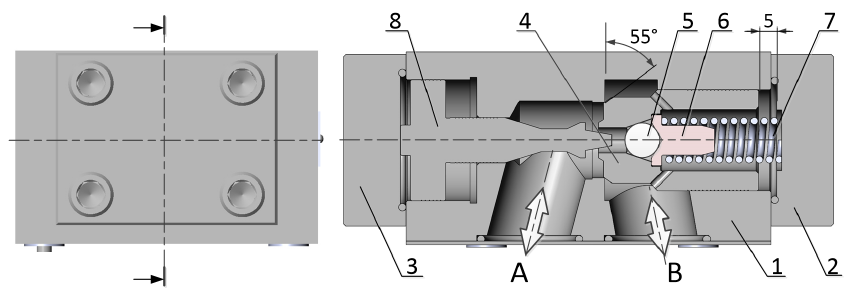
Figure 1. Scheme of the analyzed tunable check valve: 1—body, 2, 3—cover, 4—poppet, 5—ball, 6—disc, 7—spring, 8—pilot spool; A,B—connection ports.